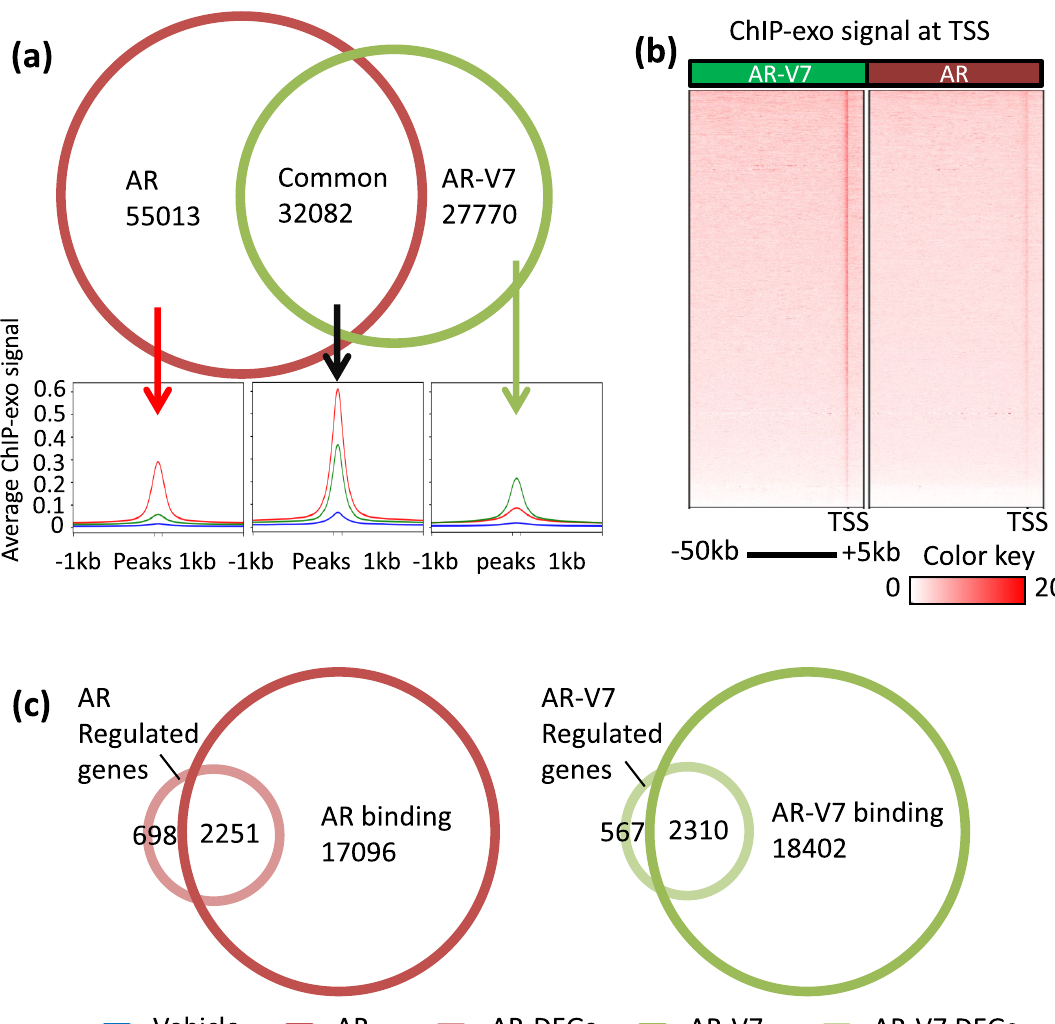
Figure 3. AR-V7 exhibits preferential binding to promoters in LNCaP AR-V7 cells. ( a ) AR isoform specific and common binding sites identified in LNCaP cells treated with R1881 or LNCaP AR-V7 cells treated with Dox in 10% CSS medium. Average ChIP-exo signals at these corresponding subsets of binding sites (indicated by arrows) are plotted below. Average ChIP-seq intensities within 1 kb distance to the center of peaks plotted as a profile of each subset from previously reported LNCaP cells treated with vehicle (Blue) 29 , LNCaP AR-V7 cells treated with 20 ng/mL Dox (green) and LNCaP cells treated with 10 nM R1881 (red) for 24 h. ( b ) AR and AR-V7 ChIP-exo signal within 50 kb upstream and 5 kb downstream of all the TSS in human genome build hg19 plotted as average signal for each 10 bp bin. TSS with only scores of zero were not included in the plot. ( c ) Integrated RNA-seq and ChIP-exo analyses reveal the AR and AR-V7 induced and repressed direct targets. Venn diagram showing number of genes with AR or AR-V7 binding sites (annotated to the nearest TSS using HOMER/BEDTools, on the same DNA strand) overlapping differentially expressed genes (FC > 1.5, adjusted p < .05). All Venn diagrams are plotted as circles proportional to the